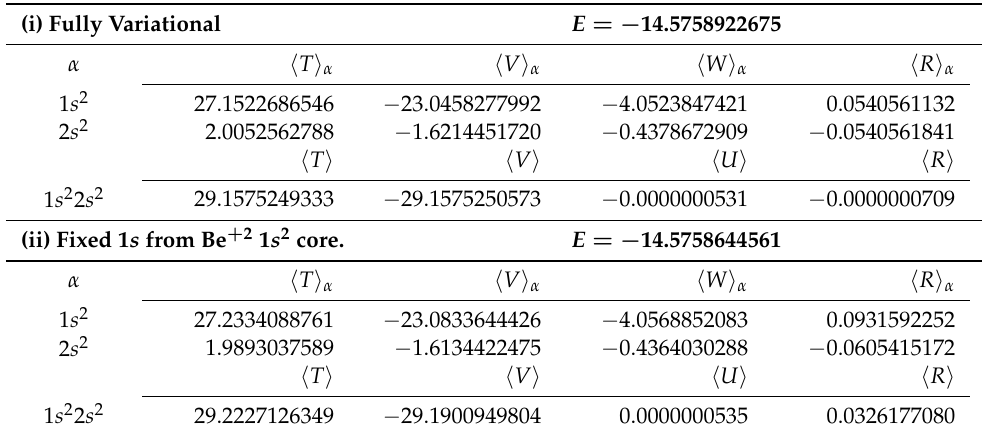
Table 6. Comparison of virial theorem analysis for a fully variational calculation for Be 1 s 2 2 s 2 and a fixed core calculation where the 1 s orbital is from the ion Be + 2 1 s 2